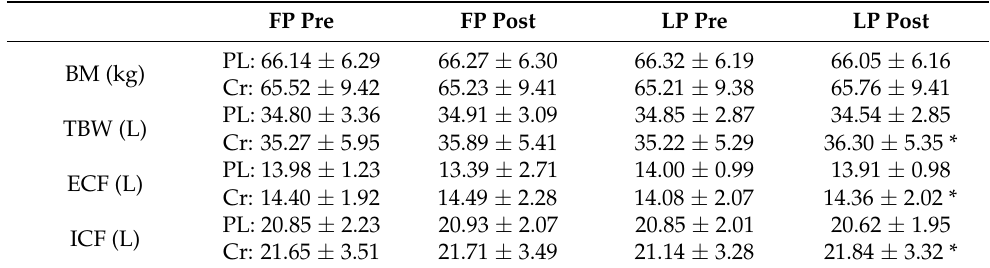
Table 2. Raw values for the body mass and fluid markers at pre- and post-supplementation visits. FP